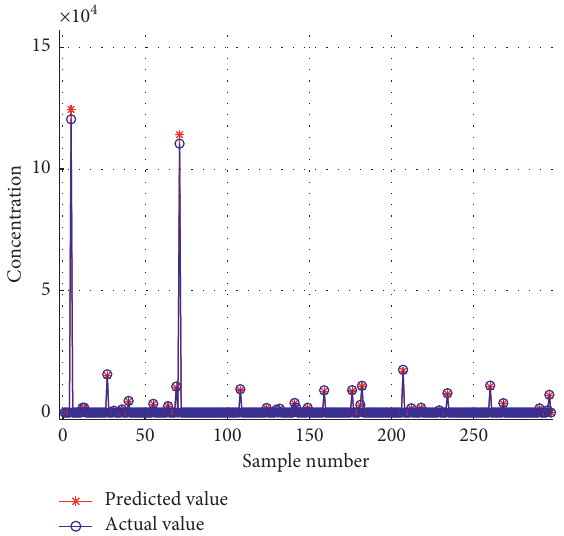
Figure 15: The Weifang test set data prediction effect